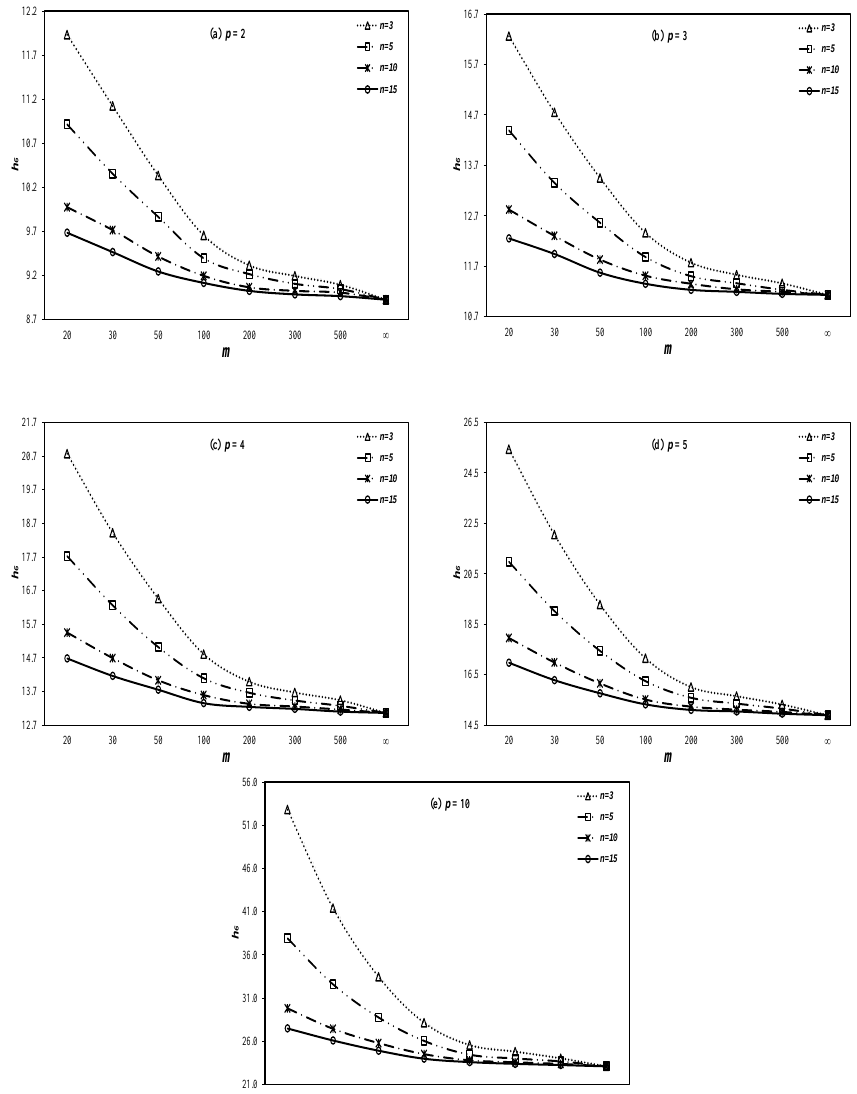
Figure 6. Control limit curves of proposed chart under estimated parameters with λ = 0.1 .